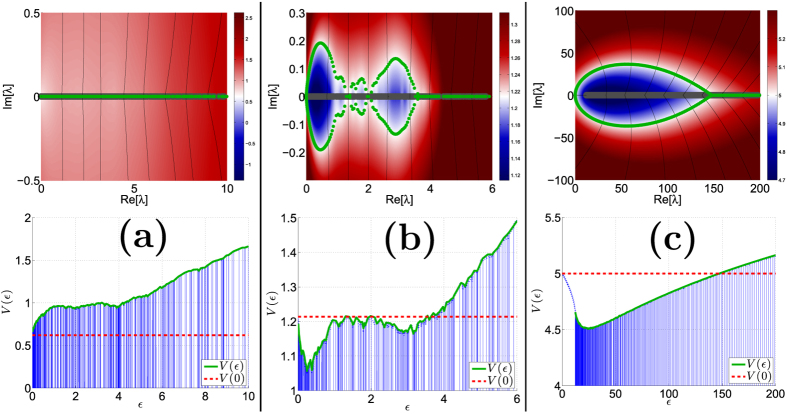
The emergence of complexity in the relaxation spectrum.The upper plot in each panel displays a representative example for a relaxation spectrum. The {λk} are indicated by green points in the complex plane. The ring has N = 500 sites. The disorder is σ = 5, hence the calculated threshold values are s1/2 = 1.77 and s1 = 2.7 and s∞ = 5. In (a) the affinity is s = 1.24 < s1/2 and the spectrum is real. In (b) the affinity is s = 2.43 and the spectrum has several complex bubbles separated by real segments. In (c) the affinity is s = 10 > s∞ and the real spectrum has a gap, while the complex spectrum is a fully developed complex bubble, tangent to the origin (no gap). The “electrostatic field” that is associated with the characteristic equation is represented by a few field-lines, while the background color provides visualization of the corresponding electrostatic potential. The spectrum is obtained by looking for the intersections of the field lines with the equipotential line V(z) = V(0) that goes through the origin (indicated in white). The lower panels plot the potential V() along the real axis. The horizontal dashed line is V(0).